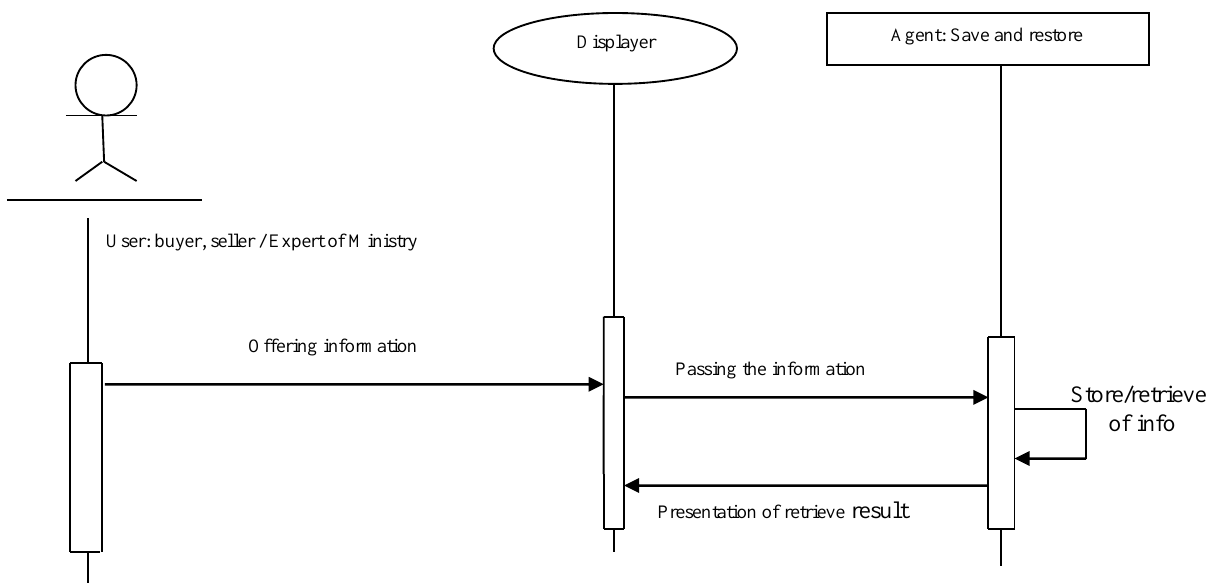
Figure 6. Interaction model for the storage and retrieval